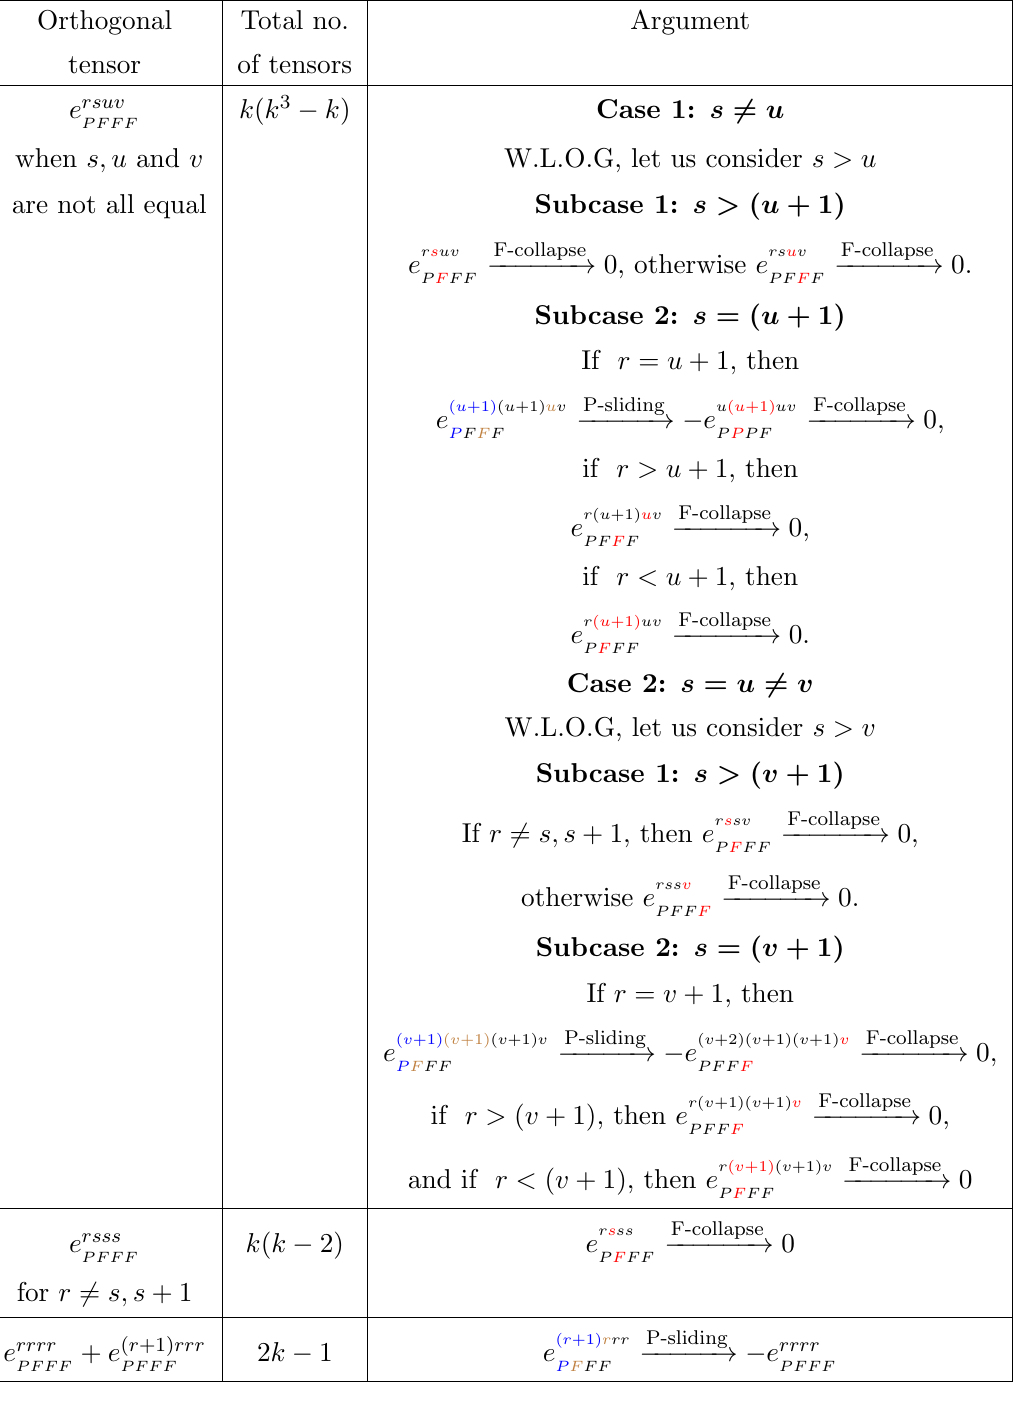
Table 7 . Arguments for the tensors in the PFFF sector orthogonal to the array of 4 point contour